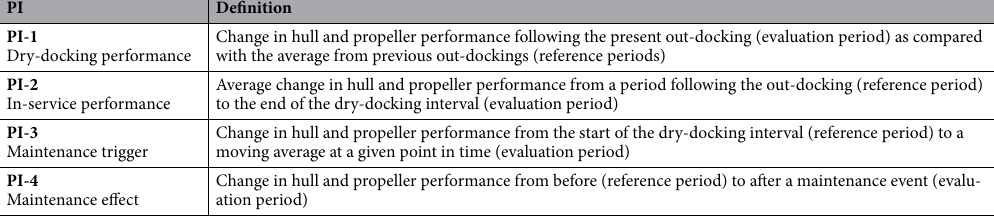
Table 4. Basic hull and propeller performance indicators